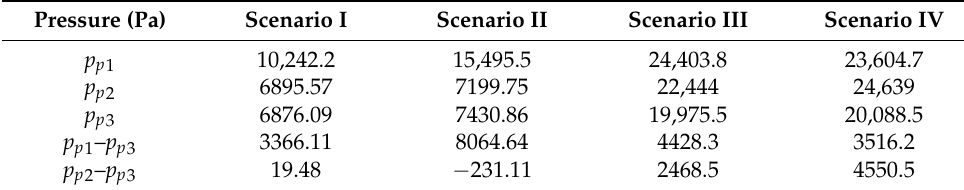
Table 4. Pressure at each point for different